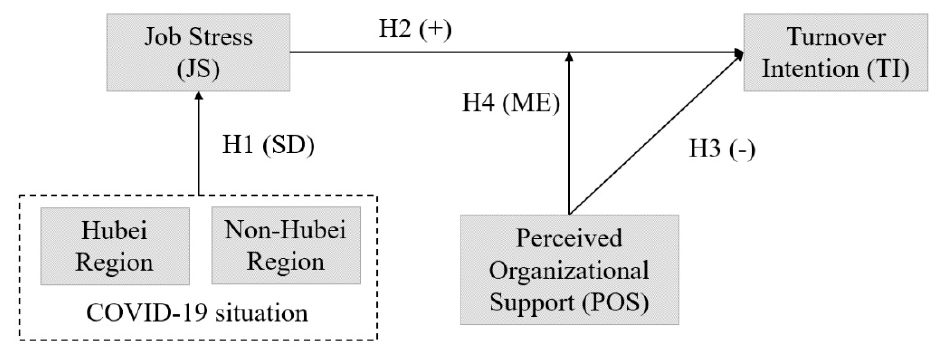
Figure 1. The theoretical framework. Note: SD, significant difference; ME, moderating effect. Source: authors’ own elaboration.